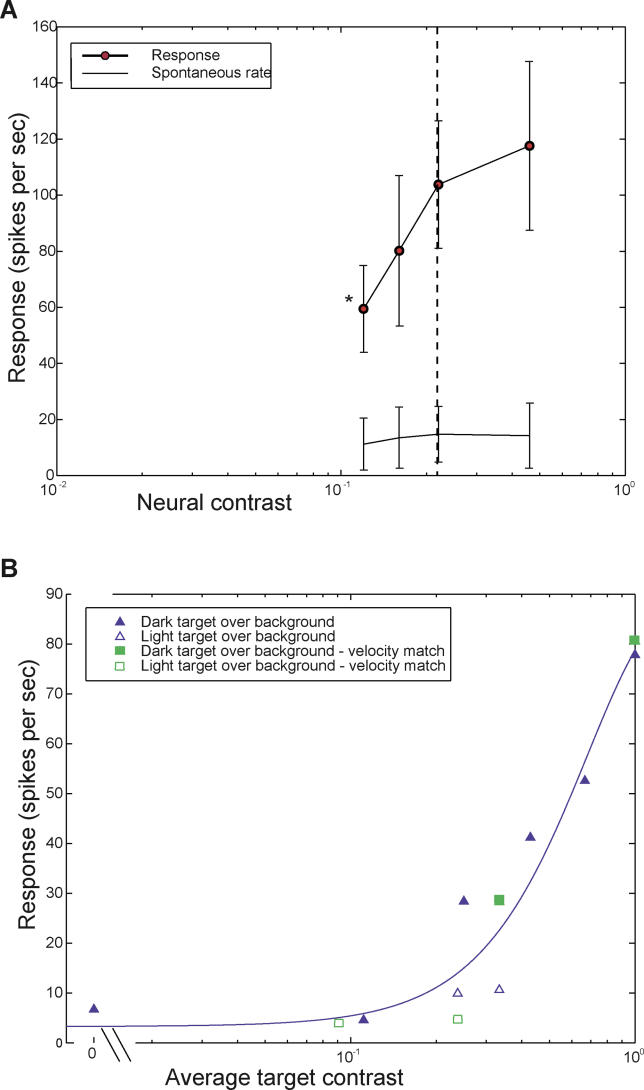
Contrast Sensitivity of STMD 2(A) The response to targets drifted against a bright background, plotted against the effective (“neural”) contrast of targets smaller than the receptive field of individual photoreceptors (see text). Data show the mean and standard error for six recordings in different animals. The dashed line denotes the effective (i.e., maximum) contrast of the targets used in (B) in which sensitivity to targets of different luminance was evaluated in the presence of confounding background motion moving in the same direction as the target. We varied the luminance of targets moving at 50°/s to be both brighter (open symbols) and darker (filled symbols) than the average of the background texture, under two conditions: moving across the background moving at 45°/s (blue triangles), or with the velocities matched at 50°/s (green squares). The graph shows the mean of three recordings from a single neuron, plotted against nominal average Michelson contrast. The solid line shows a least squares fit of a normalized Weibull function fitted through all conditions.